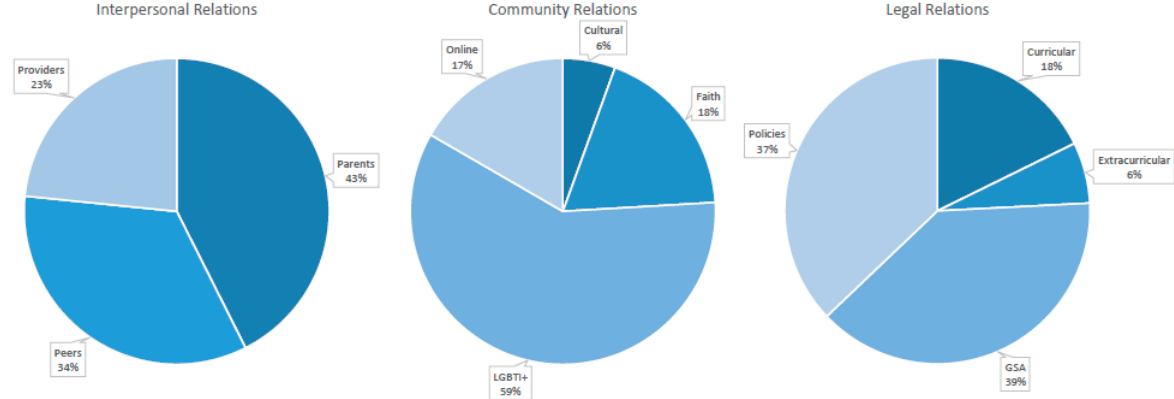
Figure 6. The proportion of interpersonal, community and legal factors across included records.